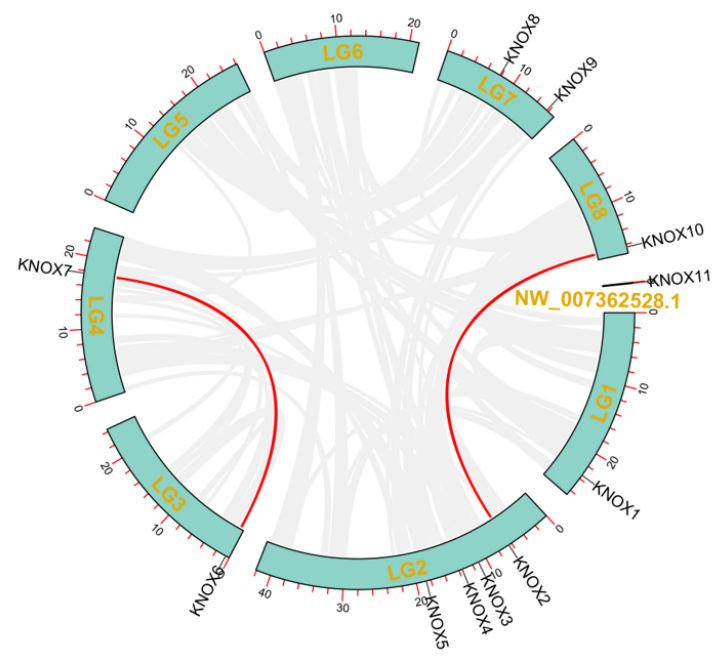
Figure 3. The distribution of the PmKNOX gene on the chromosomes and syntenic relationships. The scale on the left represents the length of chromosomes in megabases (Mb). Numbers are on each chromosome in yellow, and segmentally duplicated genes are linked with red lines.